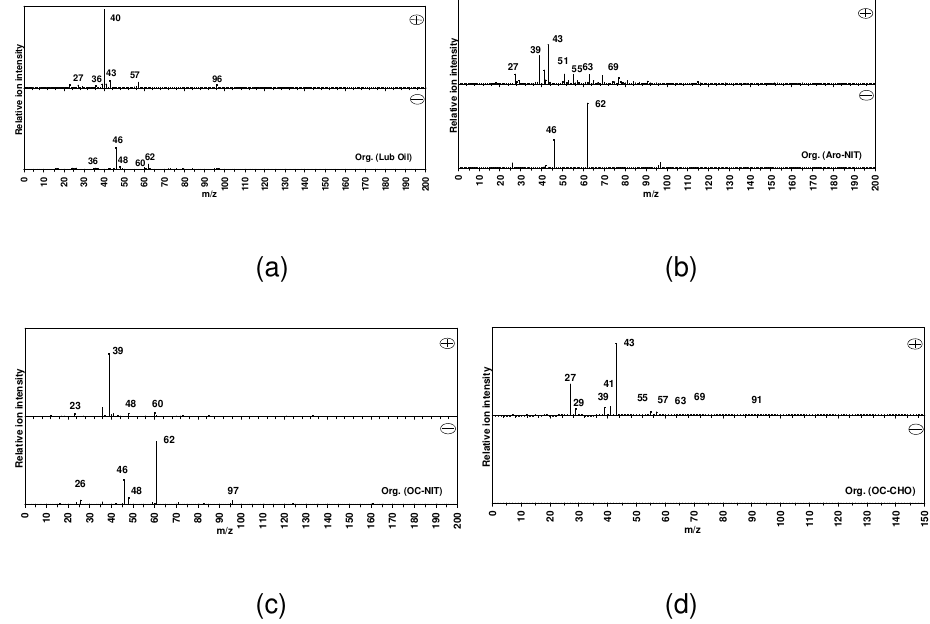
Figure 7. Average mass spectra of the four OC-rich single-particle types only observed at the RS site.